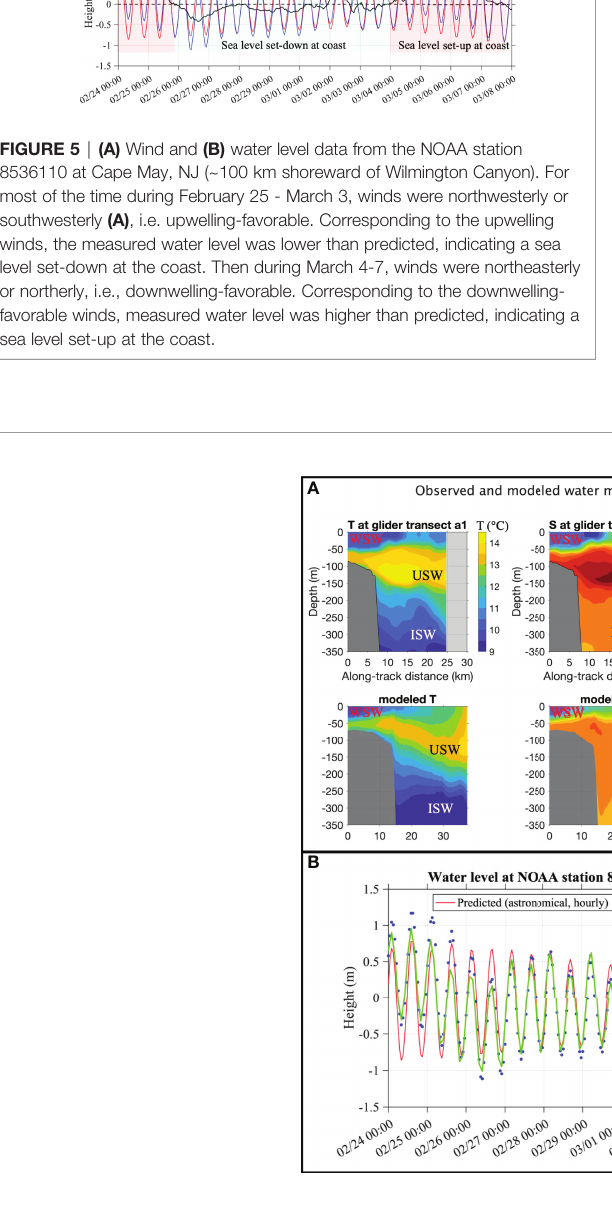
FIGURE 6 | (A) Comparison of the modeled results from SCHISM with glider observations in terms of the T/S identities and spatial distribution of water masses within the canyon. The locations of the glider transect and model transect are shown in Figure 3A . The glider transect was conducted from 22:38 Feb 28 - 18:32 Feb29 (GMT). The modeled results were averaged over 22:00 Feb 28 - 18:00 Feb 29. Bathymetry in glider transects was based on glider altimetry data. Bathymetry in modeled transects was based on GMRT data. (B) Comparison of the modeled water level by SCHISM with the predicted (based on astronomical tides) and measured water level at the NOAA station 8536110 at Cape May,